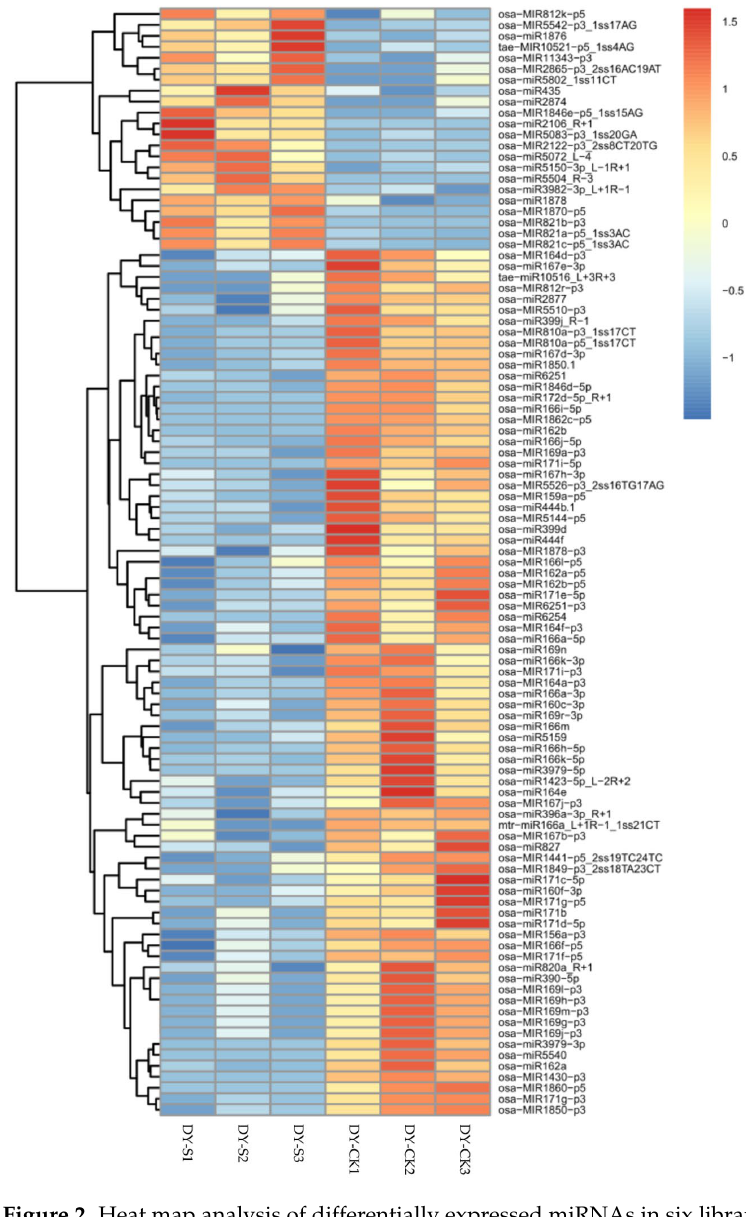
Figure 2. Heat map analysis of differentially expressed miRNAs in six libraries. Up- and downregulated genes were indicated in red and blue, respectively. Color brightness reflected the magnitude of difference.